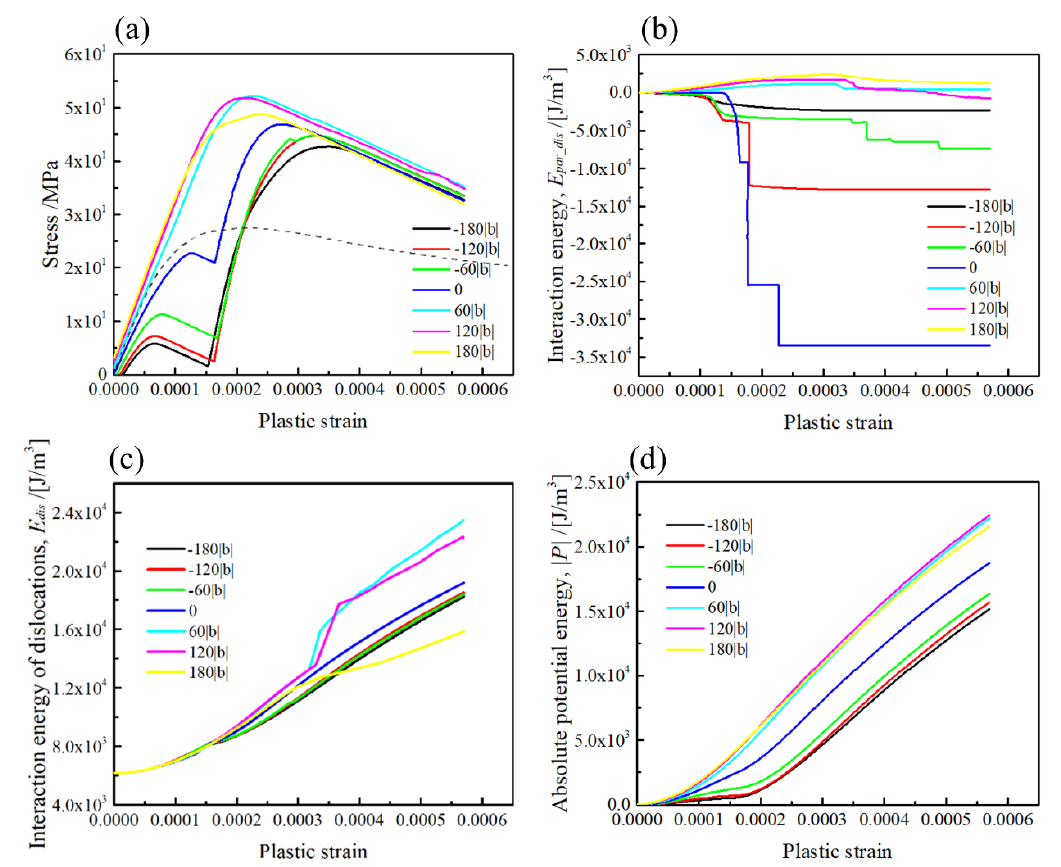
Figure 9. The geometrical effect on the misfit hardening by the [001] rod precipitate. ( a ) Stress–strain curve, ( b ) interaction energy of the precipitate and dislocation, ( c ) interaction energy of the disloca- tions, ( d ) potential energy due to the dislocation motion. The relative position of the (111) slip plane is ranging from z/|b| = −180 to 180.